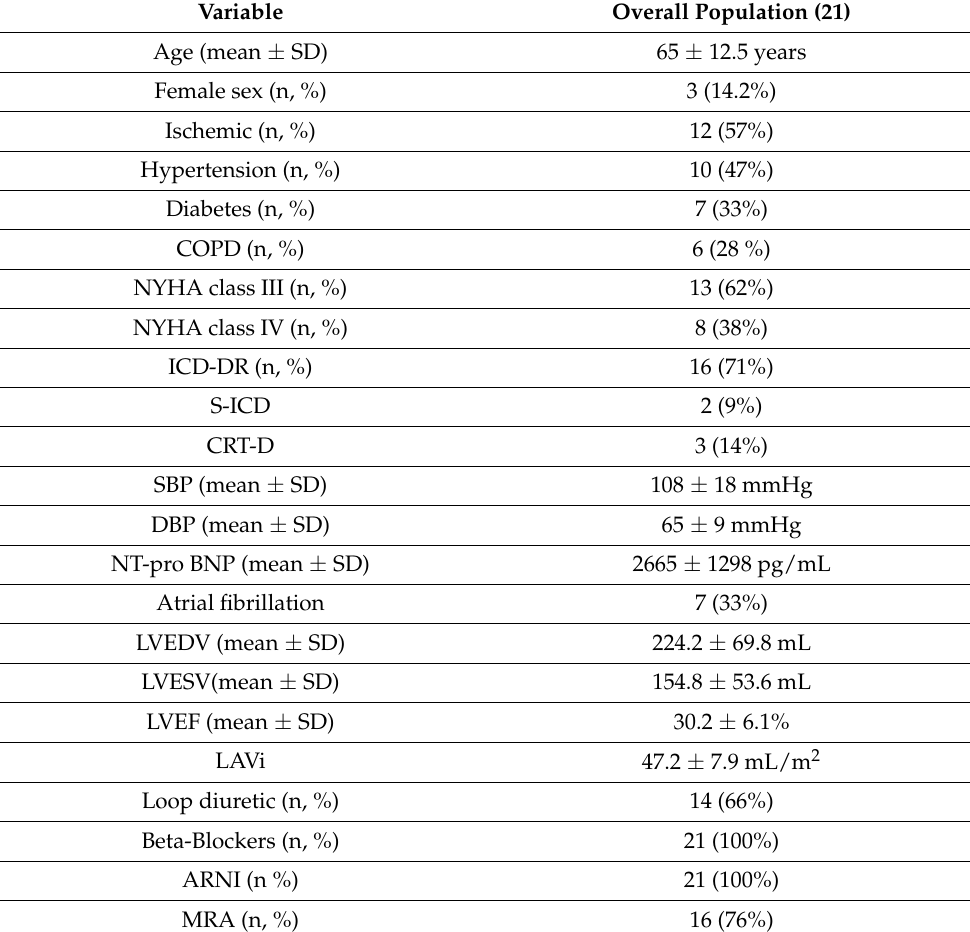
Table 1. Baseline demographic, clinical, and echocardiographic patients’ characteristics.